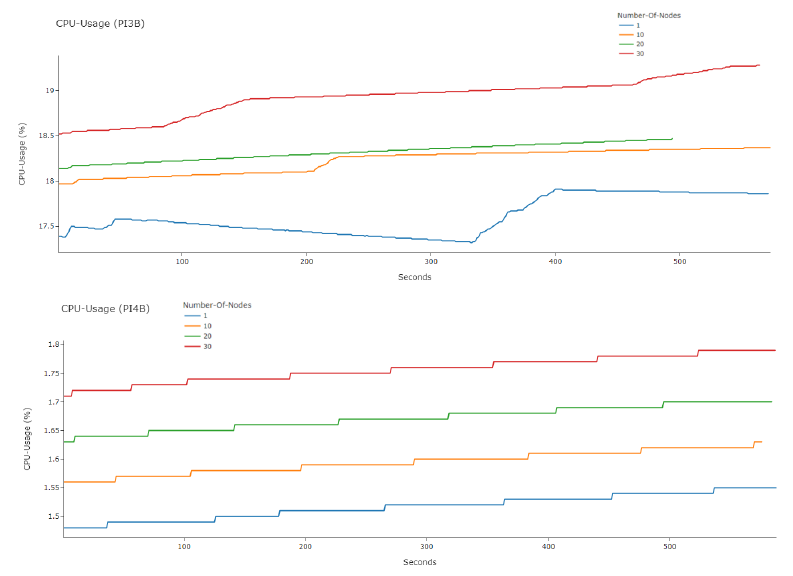
Figure 9. CPU usage on the Raspberry Pis 4B and 3B with each test